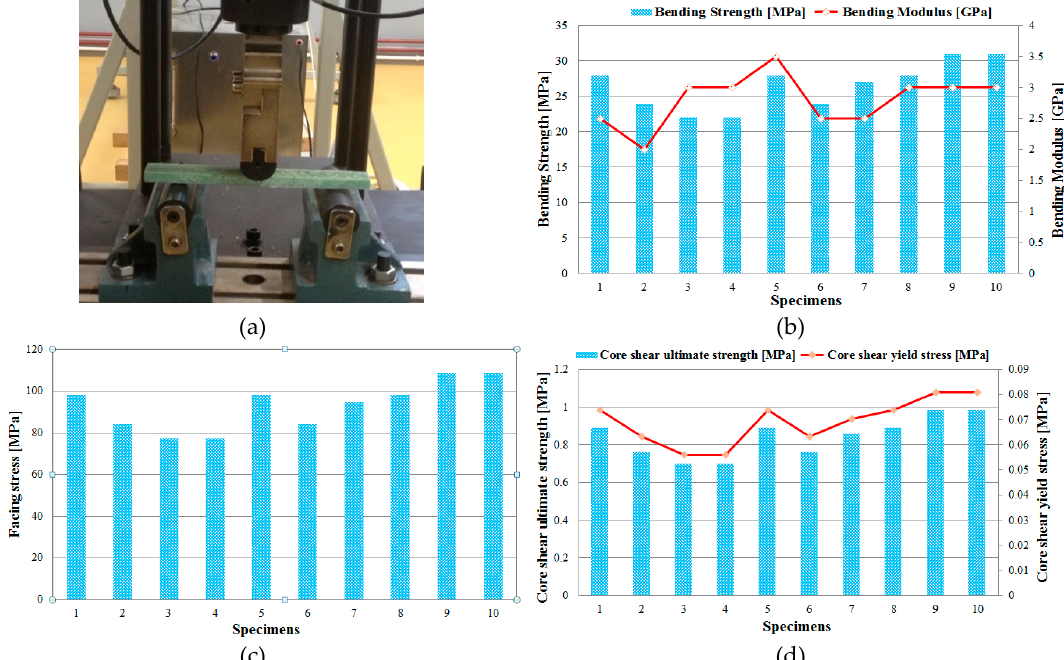
Figure 3. Three-point bending tests of the sandwich GFRP-foam specimens: ( a ) Test setup for three-point bending; ( b ) bending strengths and modulus of the GFRP-foam sandwich specimens; ( c ) facing stresses of the GFRP-foam sandwich specimens; ( d ) core shear ultimate strength and core shear yield stress of the GFRP-foam sandwich specimens.